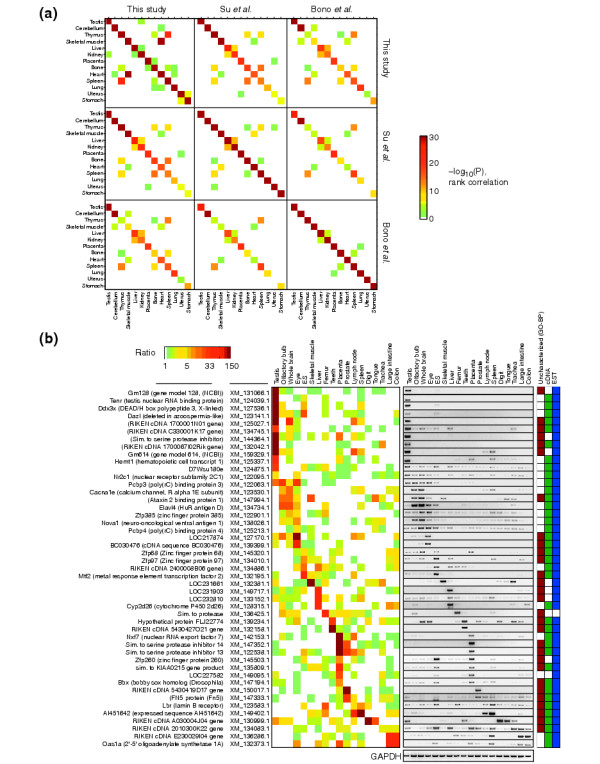
Validation of expression data by independent confirmation. (a) The P value of Spearman's Rank correlations (see Materials and methods) is shown for all possible comparisons among the 13 tissues common to all three studies (ours and those by Su et al. [15] and Bono et al. [17]) and 1,109 genes for which the same isoform is unambiguously represented on the arrays used in each of the studies (see Materials and methods). (b) Microarray data and RT-PCR results for 47 known and predicted XM genes are shown. Genes were selected to represent primarily those without GO Biological Processes (GO-BP) assignment and to encompass expression in all 18 tissues, and were biased towards those with functions predicted by support vector machines (SVMs) in categories of interest (or expressed in tissues of interest). The three columns on the far right show whether each XM gene was uncharacterized (not annotated) in GO-BP, and whether it is represented by a cDNA or EST.